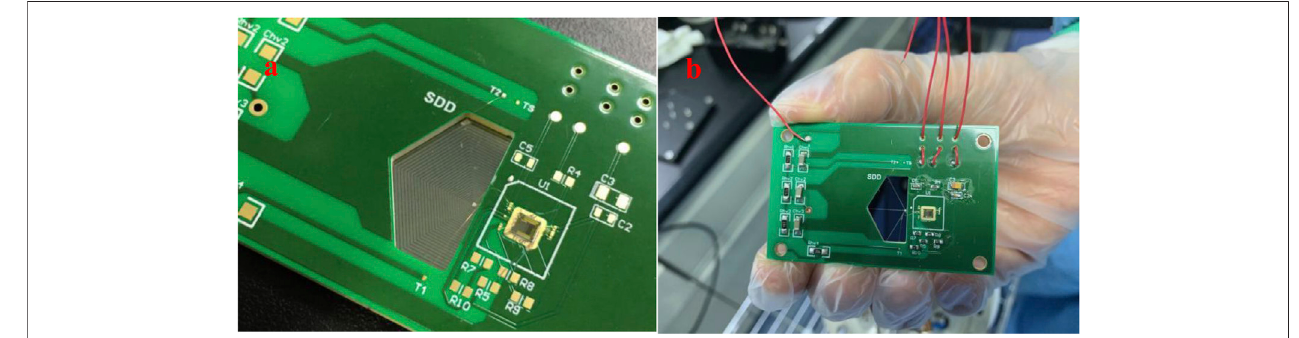
FIGURE 7 | (A) DSSH-SDD and electronics integrated assembly and (B) schematic diagram of the preampli fi er circuit after wiring.